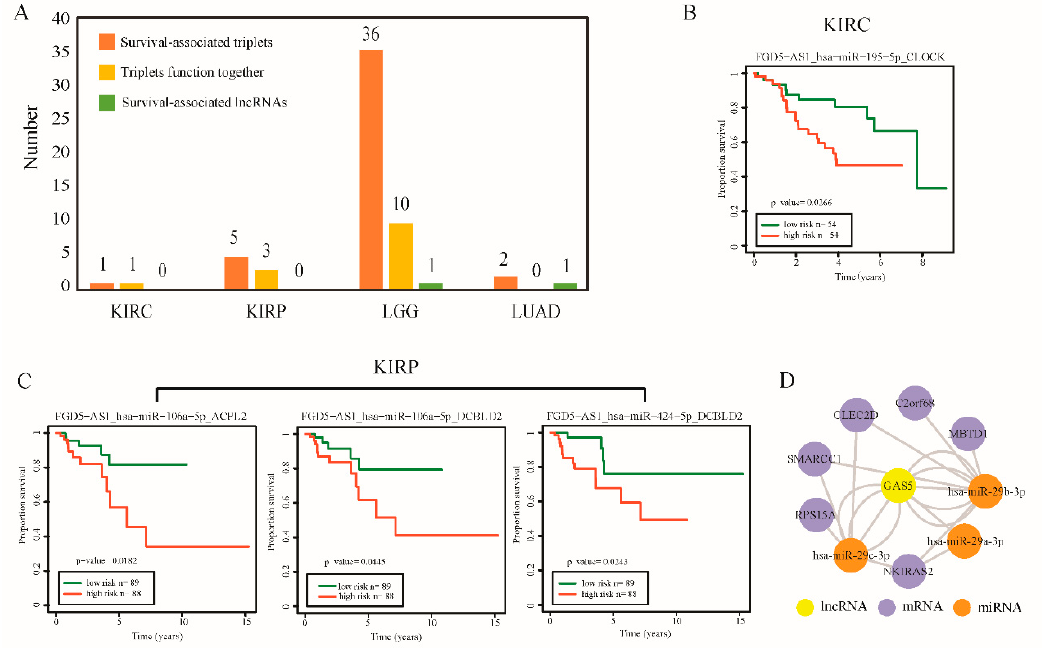
Figure 5. LncRNA-perturbated triplets with potential prognosis capacity across cancer types. Figure 5. LncRNA ‐ perturbated triplets with potential prognosis capacity across cancer types. ( A ) ( A ) Number of the identified prognosis-related signatures across cancer types. Number of the identified prognosis ‐ related signatures across cancer types. (Survival ‐ associated triplets: survival ‐ associated triplets identified from 109 lncRNA ‐ perturbated triplets; triplets function together: Triplets associated with overall patient survival though their single factor did not associate with patient survival; survival ‐ associated lncRNAs: survival ‐ associated lncRNAs identified from lncRNA perturbators). ( B ) Kaplan–Meier estimates the overall survival using the triplet “ FGD5 ‐ AS1 _ hsa ‐ miR ‐ 195 ‐ 5p _ CLOCK ”(category: Triplets function together) in KIRC dataset. ( C ) Kaplan– Meier estimates the overall survival using the 3 FGD5 ‐ AS1 ‐ perturbated triplets (category: Triplets function together) in KIRP dataset. ( D ) The GAS5 ‐ mediated survival ‐ related module (category: Triplets function together) in LGG. Lower grade glioma, LGG; kidney clear cell carcinoma, KIRC; kidney papillary cell carcinoma, KIRP; lung adenocarcinoma, LUAD; prostate cancer, PRAD.